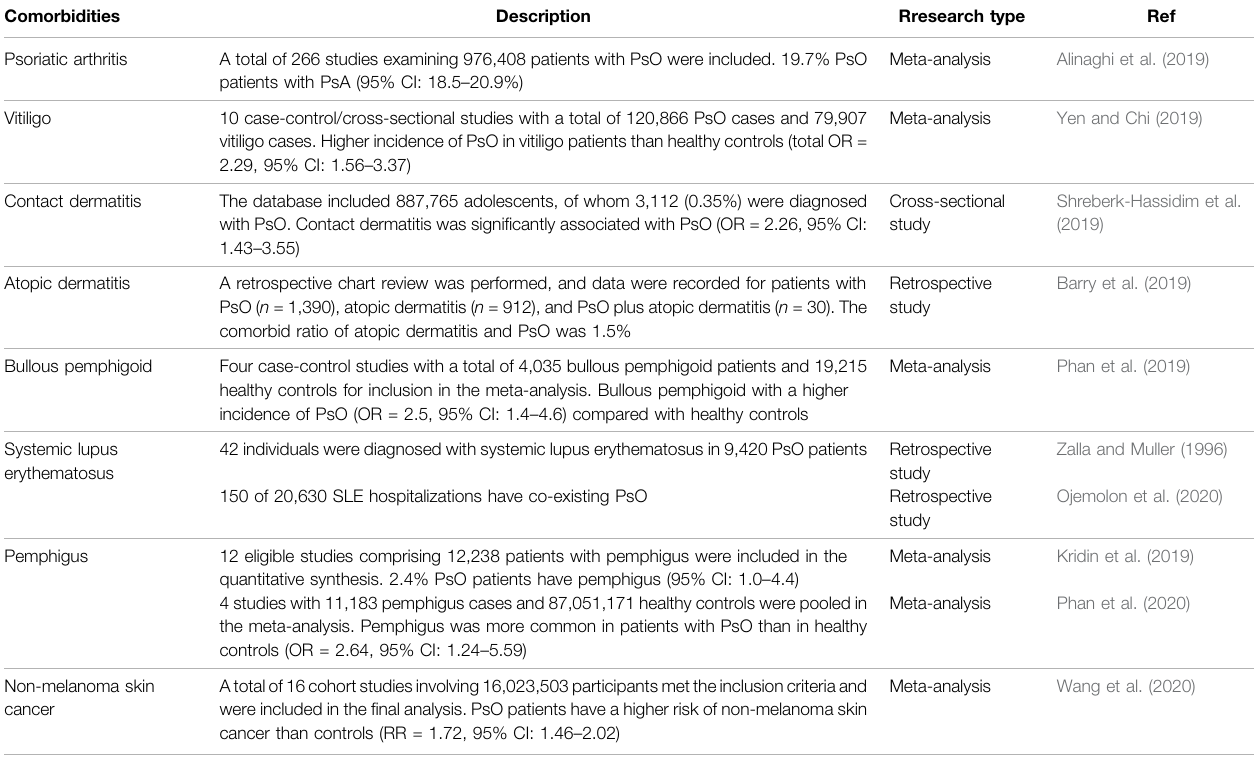
TABLE 1 | Summarization of epidemiological studies between PsO and its comorbidities (skin diseases) a